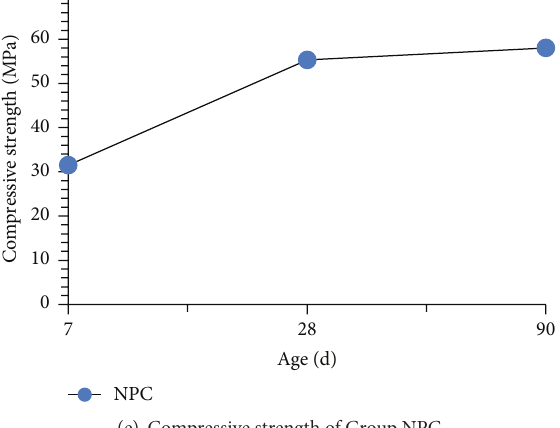
Figure 1: Compressive strength of pastes with different